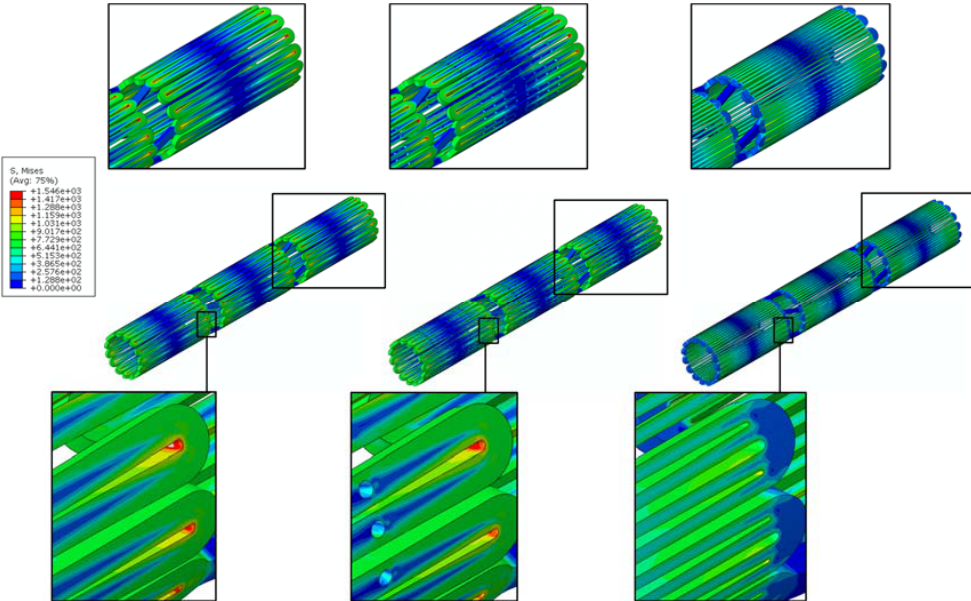
Figure 7. FEA contour plot comparison of von Mises stress distribution at 2.0 mm after crimping into a catheter among the conventional DES stent ( left ), conventional depot stent ( middle ), and rhombic ‐ shaped channel stent ( right ).